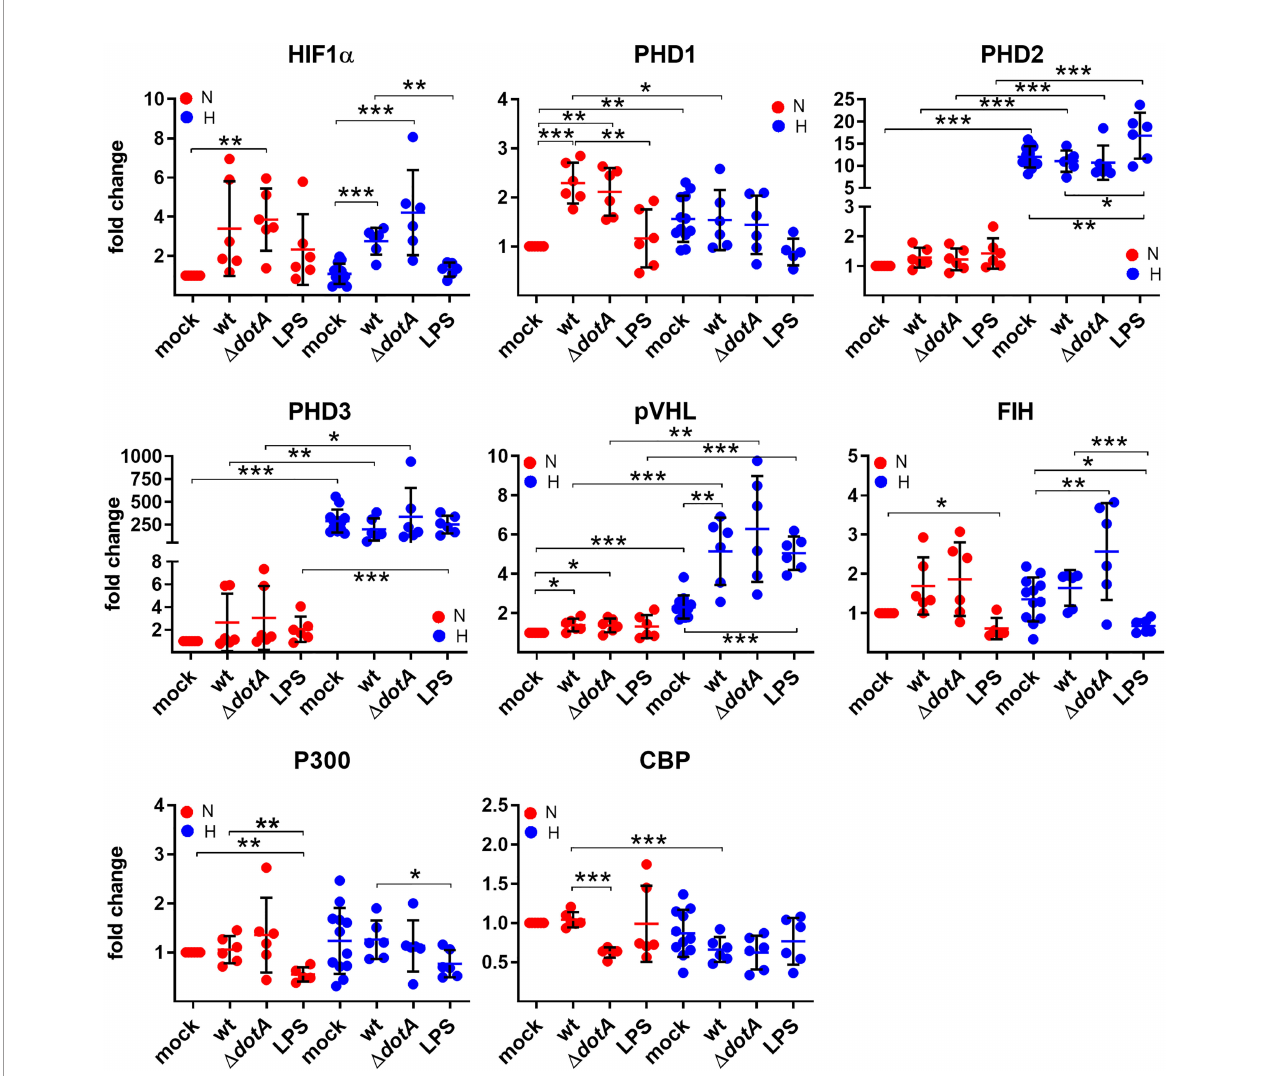
FIGURE 5 | C. burnetii only marginally in fl uences the expression of genes regulating HIF1 a stability. BMDM were either uninfected (mock), infected with C. burnetii (wt), the T4SS transposon mutant ( D dotA ), or treated with LPS (100 ng/ml) for 24 h under normoxia (N) and hypoxia (H). Using qRT-PCR, the gene expression of